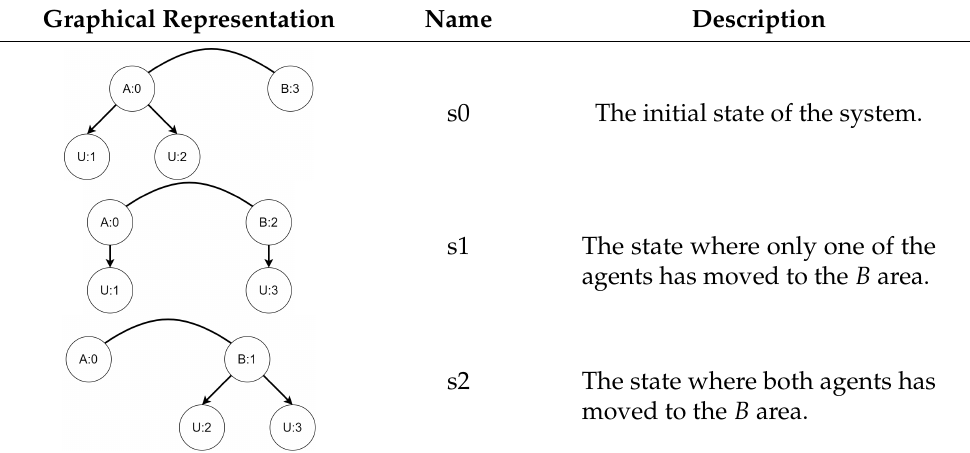
set for the introductory example. B